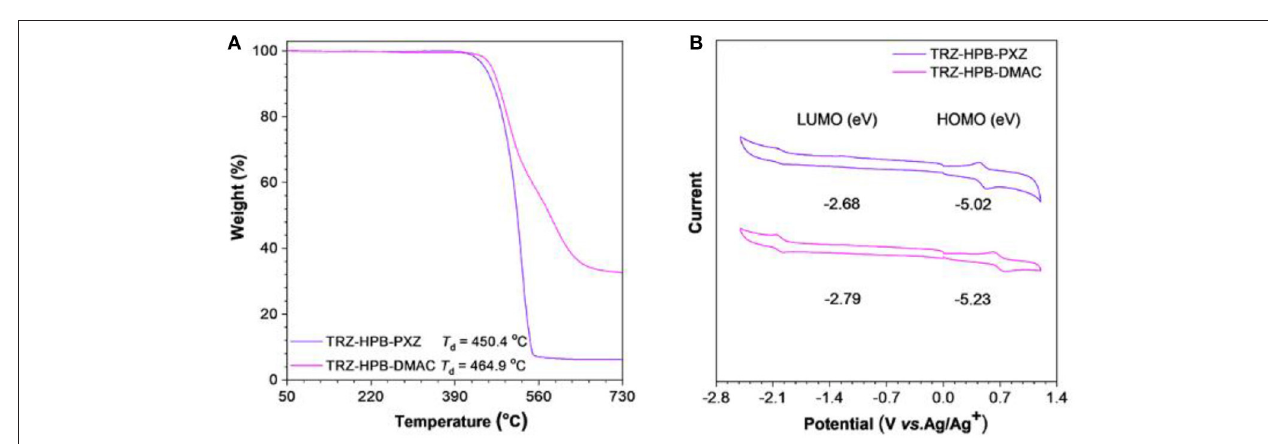
Frontiers in Chemistry |